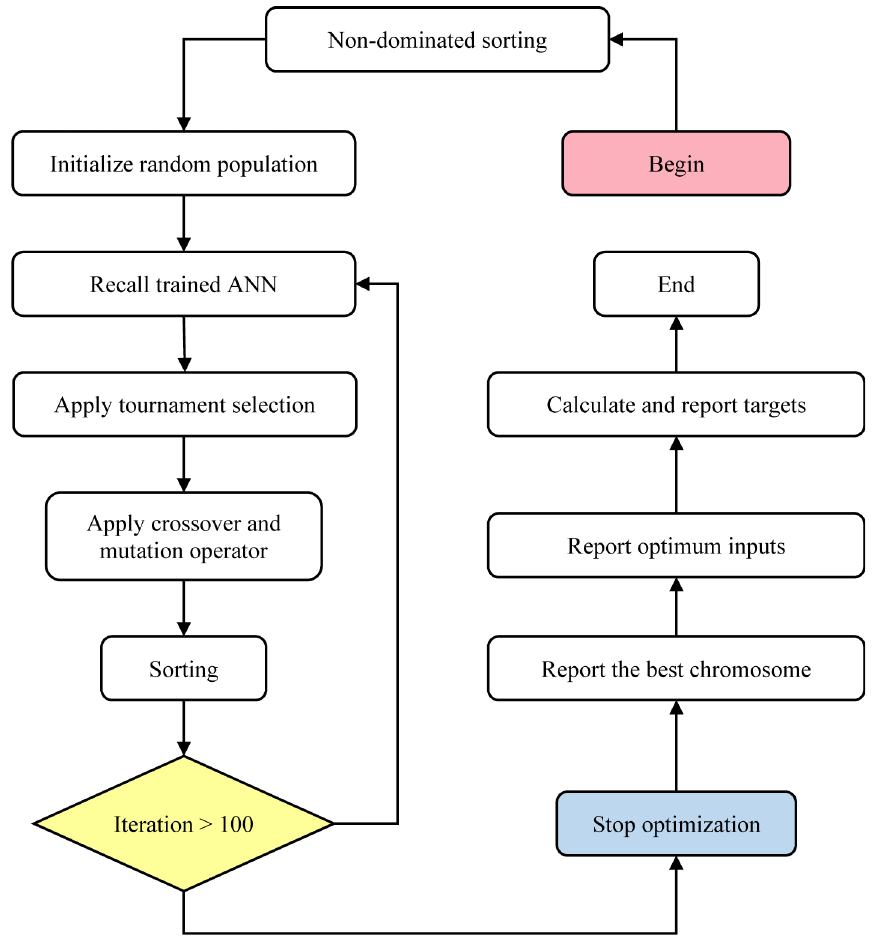
Figure 3: Flowchart of NSGA-II based